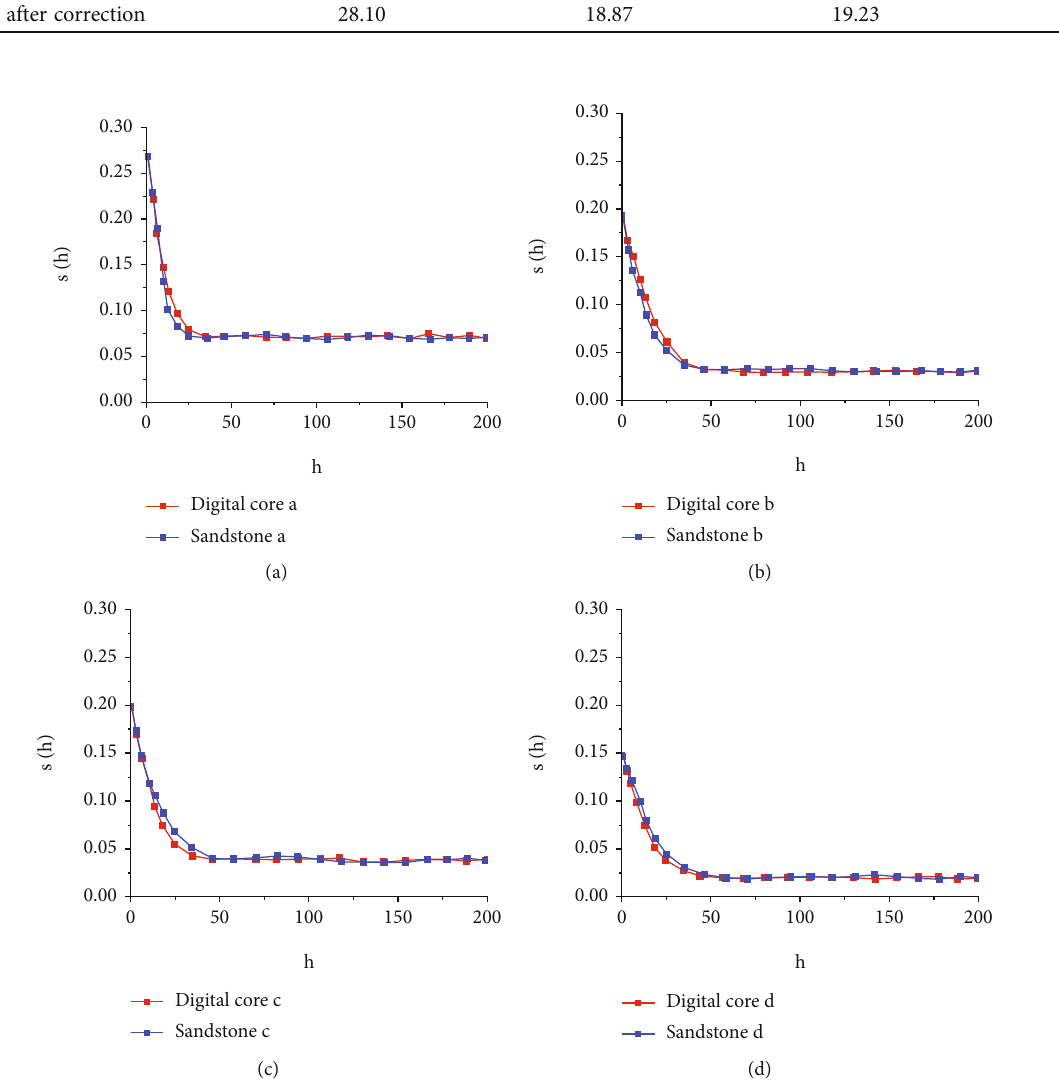
Figure 13: Autocorrelation functions: (a) digital core a and sandstone a, (b) digital core b and sandstone b, (c) digital core c and sandstone c, and (d) digital core d and sandstone